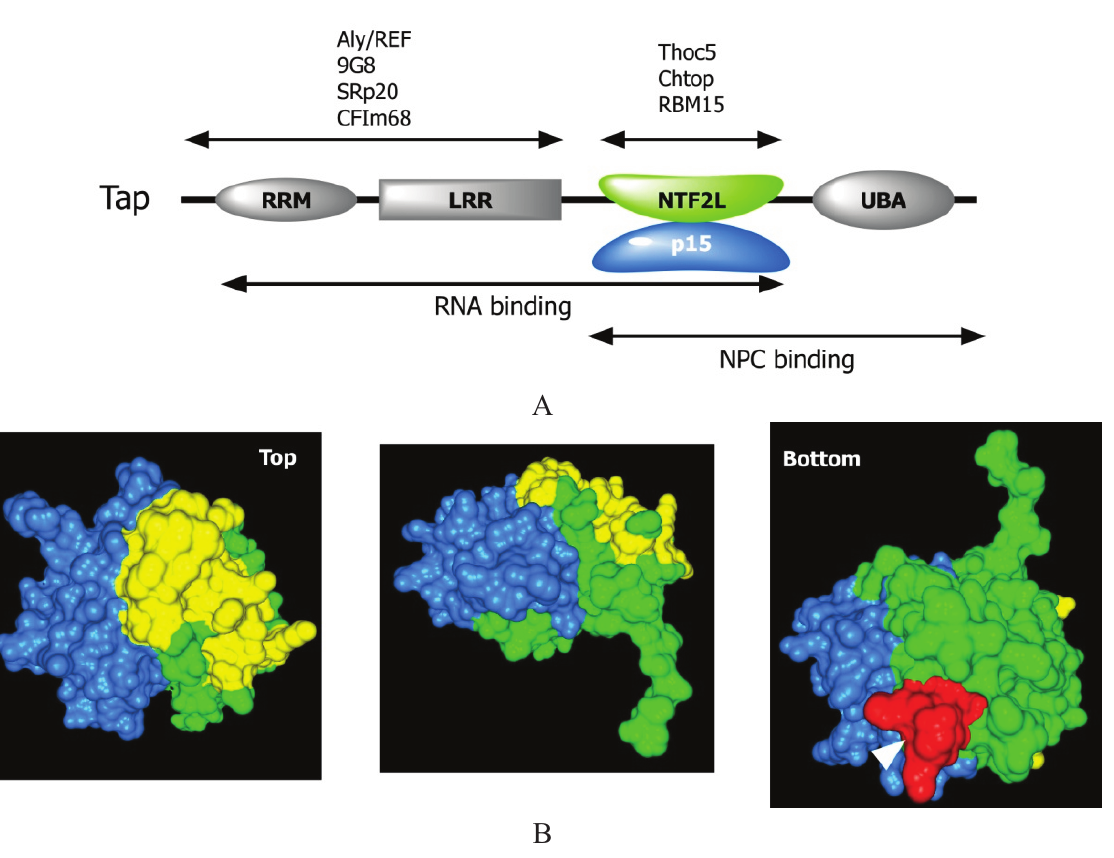
Figure 2. Structure and function of the principal mRNA export receptor Tap-p15. ( A ) Tap consists of an RNA recognition motif (RRM), leucine-rich repeat (LRR), nuclear transport factor 2-like (NTF2L) and ubiquitin-associated (UBA) domains. These domains are